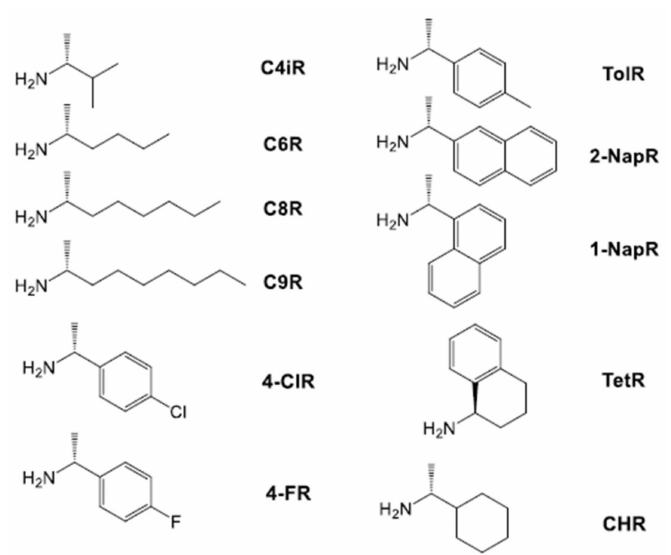
Figure 6. Chiral amines used to probe their directing effect on mixtures of peptide enantiomers.